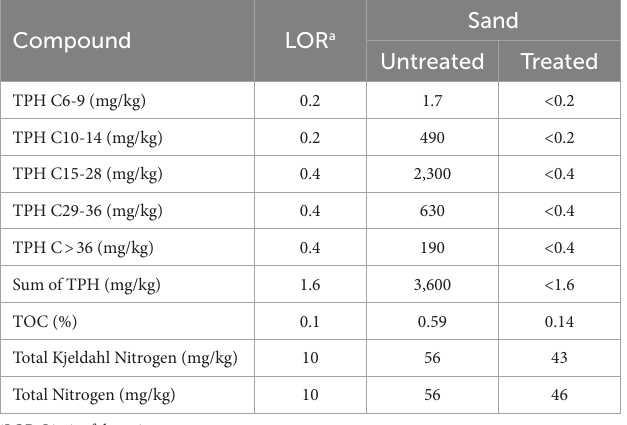
TABLE 1 Chemical composition of treated and untreated sand used as deposits in the UDMC test. Compound LOR a